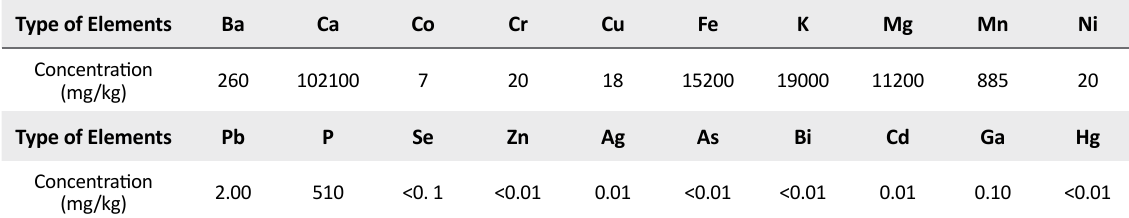
Table 6. X-ray Fluorescence Spectrometry (XRF) analysis of the collected soil samples Type of